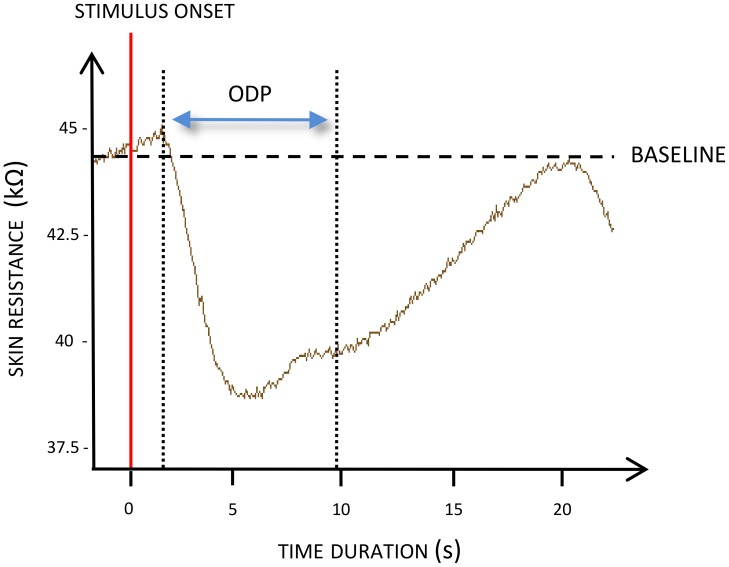
A representative example of OPD during MI (S07).